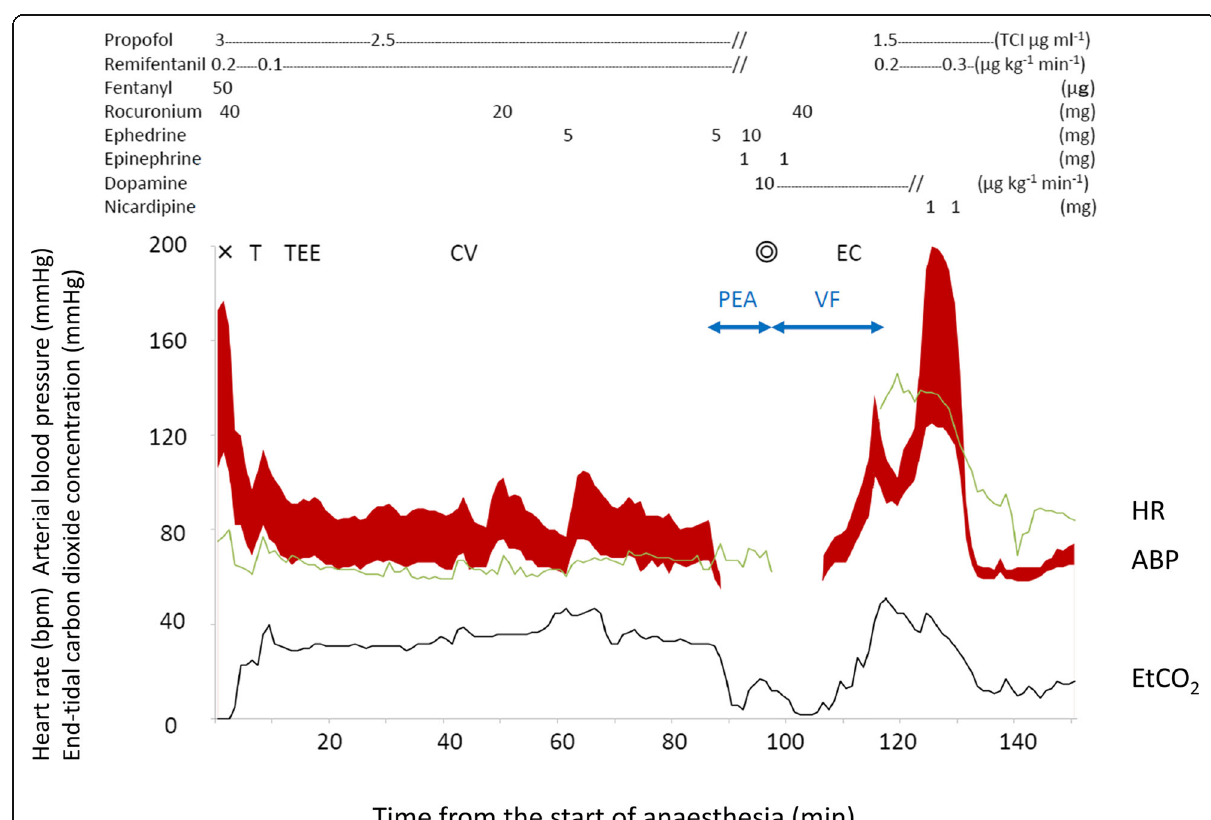
Fig. 3 Cardiopulmonary events under anesthesia. The patient went into cardiopulmonary arrest 90 min after induction of general anesthesia. The surgical procedure was initiated while cardiac compressions were being performed and cardiopulmonary bypass was established, with recovery of the cardiac rhythm at 25 min after cardiopulmonary arrest. The horizontal axis of the graph represents the time (min) after induction of anesthesia, with the following variables plotted on the vertical axis: arterial blood pressure (ABP: red band graph [mmHg]), heart rate (HR: green line [bpm]), and end-tidal carbon dioxide concentration (EtCO 2 : gray line [mmHg]). Multiplication sign: induction of anesthesia; T: tracheal intubation; TEE: insertion of transesophageal echocardiography probe; CV: insertion of central venous catheter; bullseye symbol: start of the surgery; EC: establishment of extracorporeal circulation; PEA: pulseless electrical activity; VF: ventricular